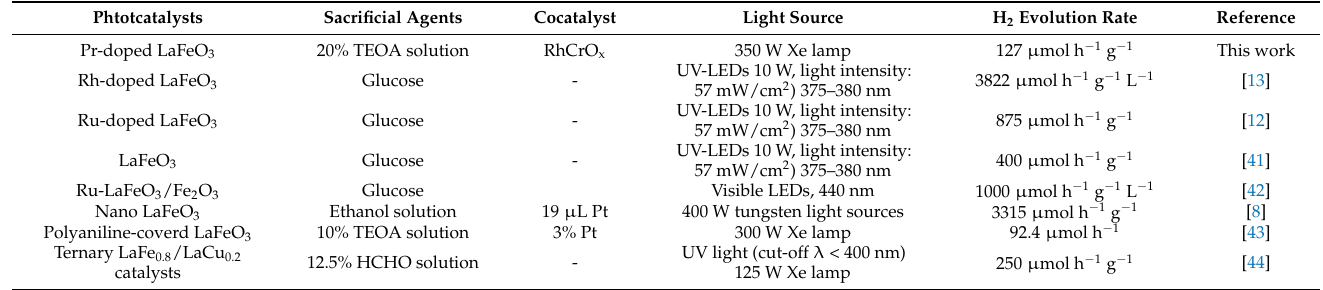
Table 3. Comparison of H 2 evolution rate of LaFeO 3 -based photocatalysts